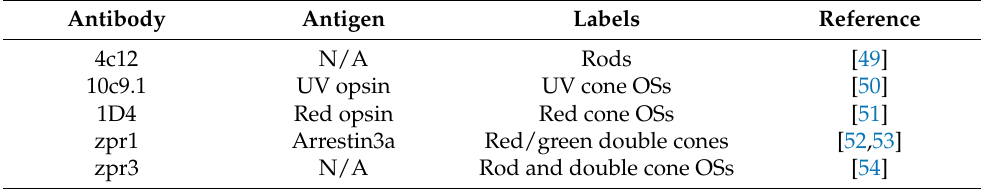
Table 2. Examples of commonly used antibodies that label zebrafish